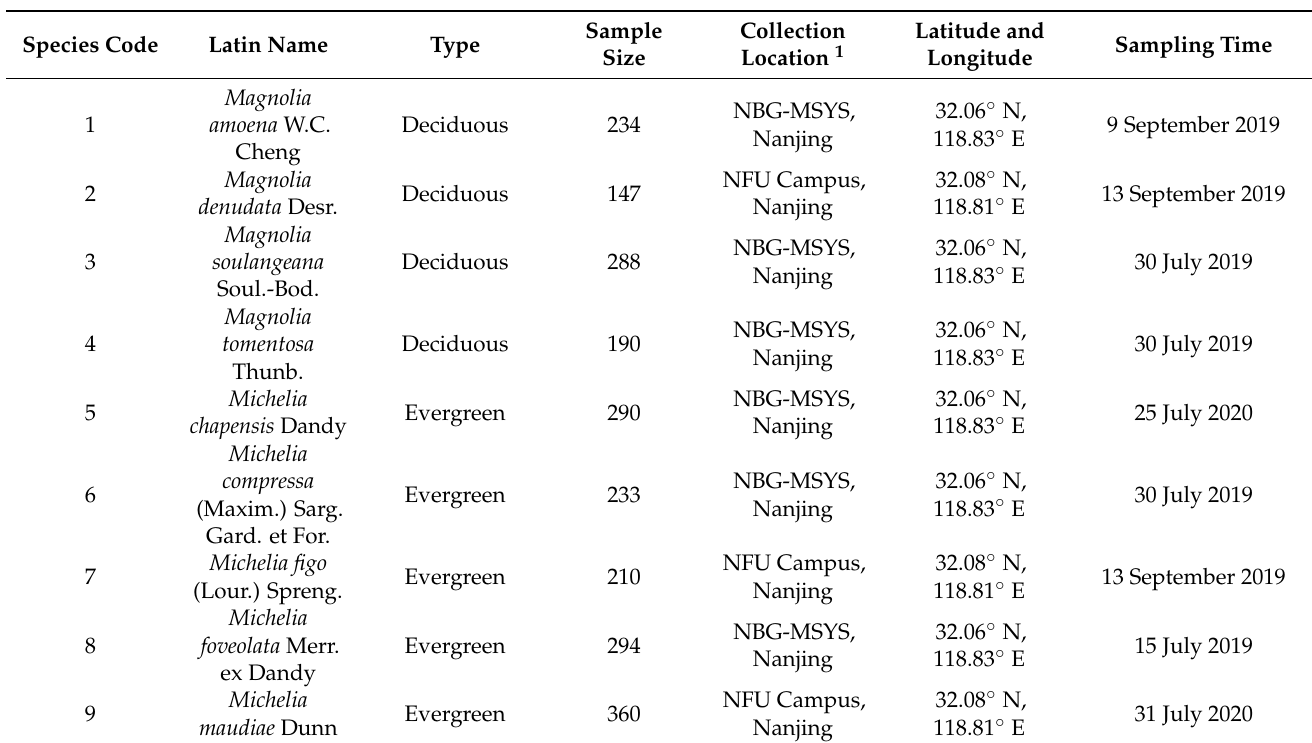
Table 1. Species collection